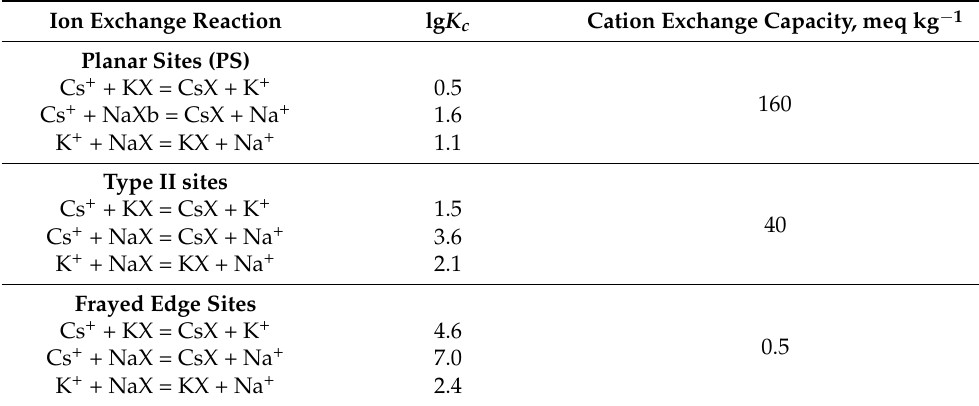
Table 4. Ion exchange reactions and selectivity coefficients ( Kc ) at “planar sites”, “type II sites” and “frayed edge sites” (data from